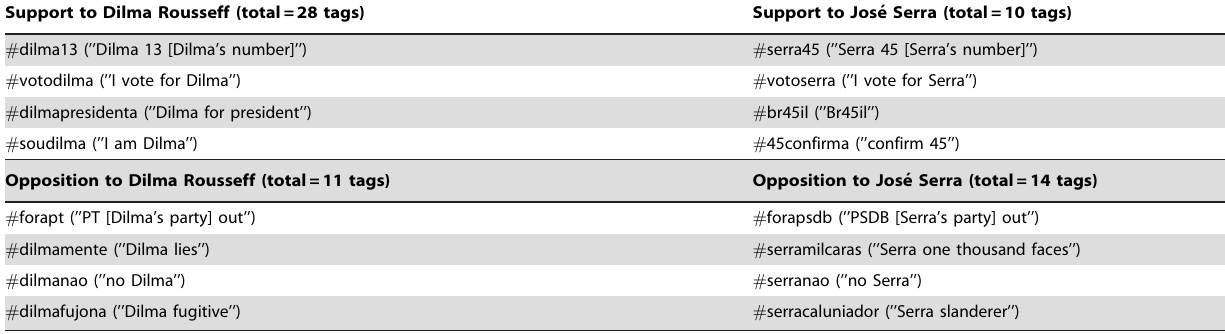
Table 1 Examples of hashtags which form the subdatasets